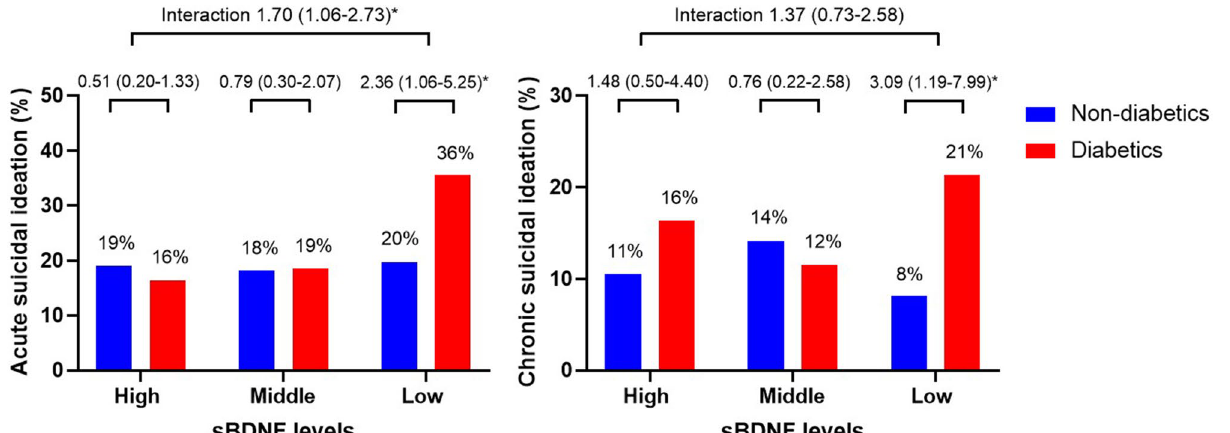
Figure 1. Interaction effects of diabetes and the sBDNF tertile on acute and chronic suicidal ideation in patients with acute coronary syndrome. Data are odds ratios (95% confidence interval) adjusted for age, sex, education, housing, current unemployment, previous depression, BDI score, hypertension, hypercholesterolemia, current smoking, and LVEF evaluated at baseline. *P < 0.05.